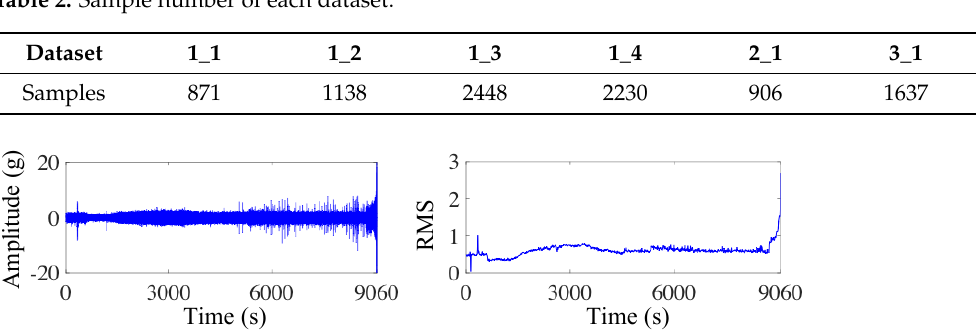
Figure 7. Vibration signals and RMS of bearing